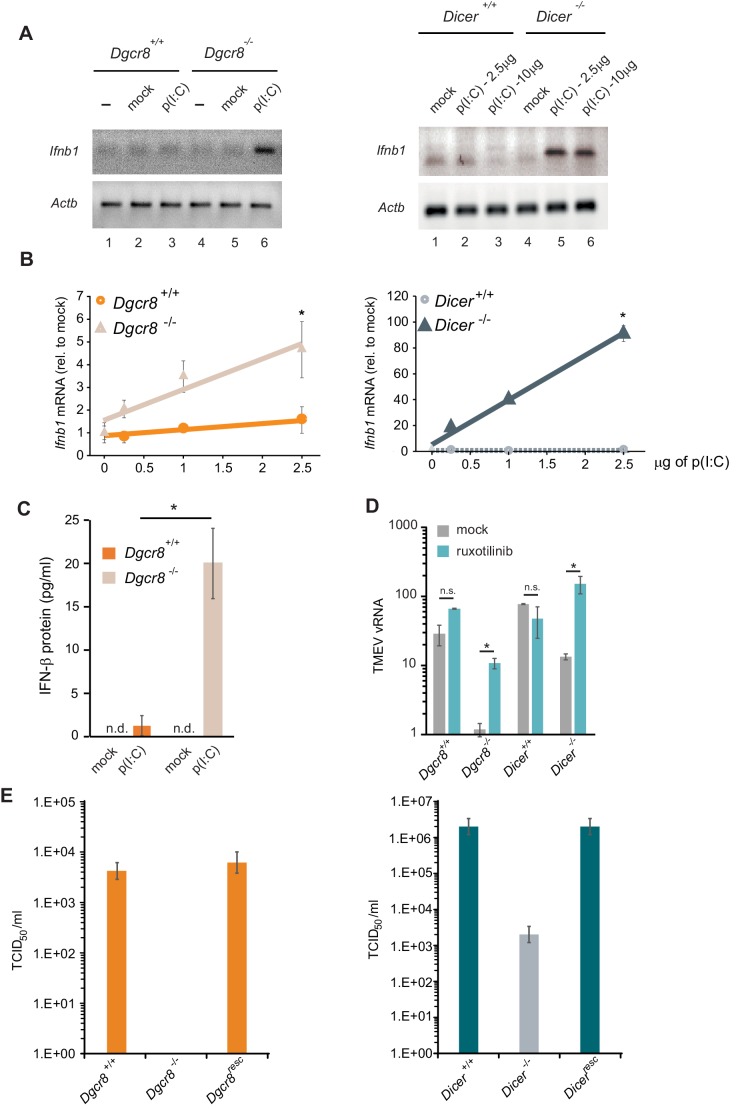
miRNA-deficient ESCs express IFN in response to dsRNA.(a) RT-PCR of poly(I:C) activated ESCs. Only Dgcr8 -/- (lane 6, left panel) and Dicer -/- (lane 5 and 6, right panel) express detectable Ifnb1 transcript (top panels). Actb amplification serves as a loading control. (b) Ifnb mRNA quantification by qRT-PCR after increasing amounts of poly(I:C) in Dgcr8-/- and Dicer-/- mESCs. Data show the average (n = 3)±s.d., normalized to mock, (*) p-value<0.05 by t-test. (c) IFN-β ELISA analyses from mock and poly(I:C) stimulated wild-type and miRNA-deficient ESCs. Data show the average (n = 3)±s.d., (*) p-value<0.05 by two-tailed T test (d) TMEV vRNA quantification in wild-type and miRNA-deficient cell lines after mock or Ruxolitinib treatment (JAK1/2 inhibitor). Data show the average (n = 3)±s.d., (*) p value < 0.05 by Student’s t-test, n.s. non-significant (e) TCID50 quantification after TMEV infection of Dgcr8 (left) and Dicer (right) rescued cell lines.